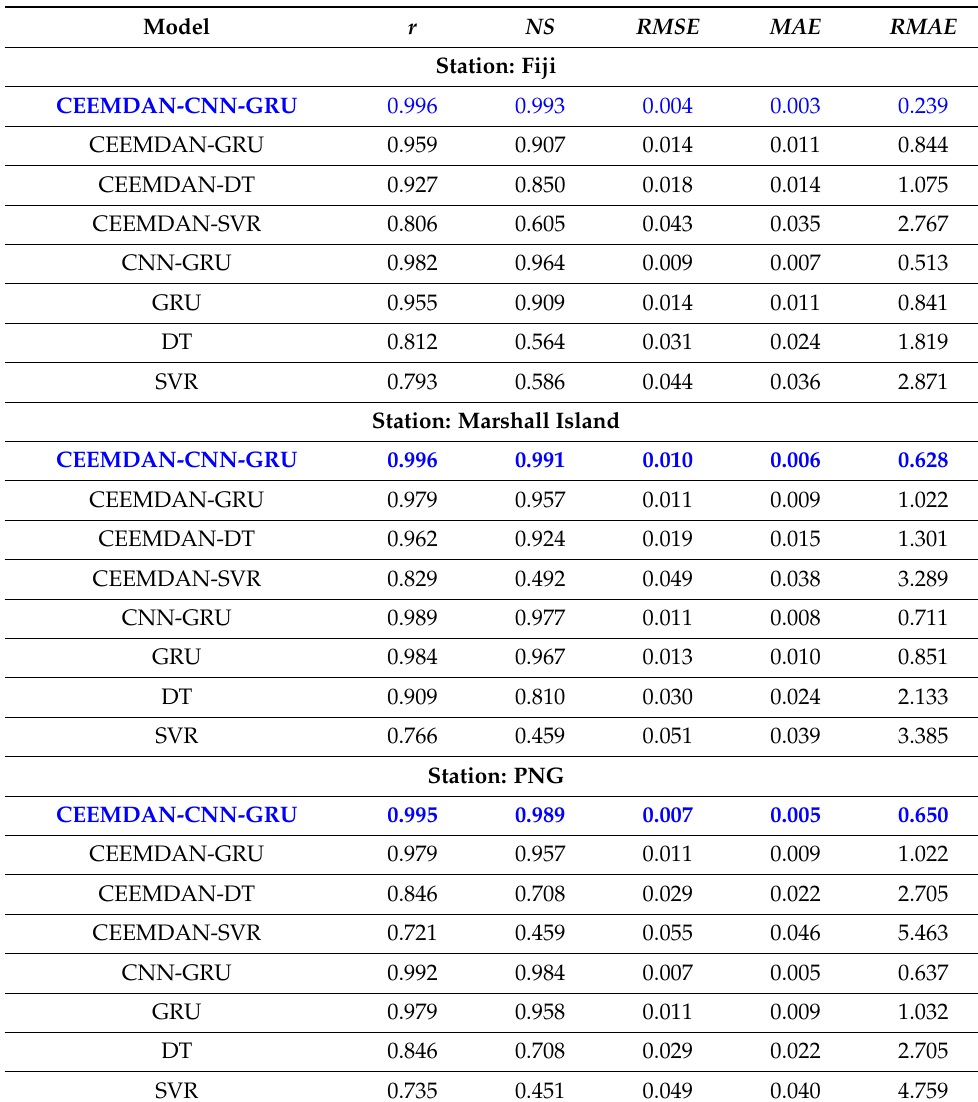
Table 3. Results of the hybrid CEEMDAN-CNN-GRU vs. benchmark (CNN-GRU, CEEMDAN-GRU, GRU) models for three study sites. The correlation coefficient ( r ), root mean square error ( RMSE ; m), mean absolute error ( MAE ; m), relative mean absolute error ( RMAE ; %) and Nash–Sutcliffe coefficient, NS ) are computed between forecasted and observed mean sea level (MSL) in the testing phase. The optimal model is boldfaced